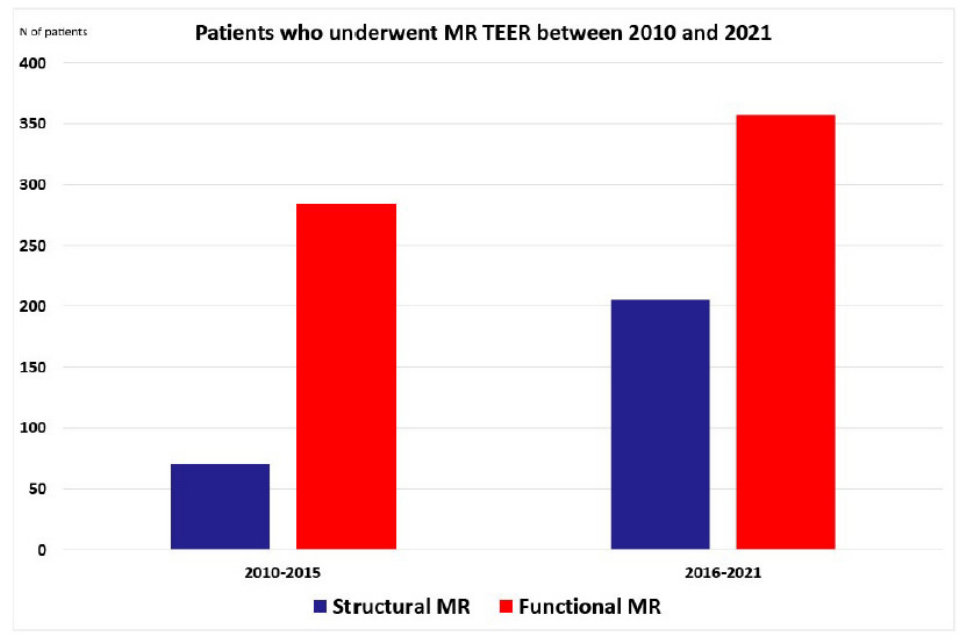
Figure 1. Patients who underwent MR TEER between 2010 and 2021. MR—mitral regurgitation, N—number, TEER—transcatheter edge-to-edge repair.